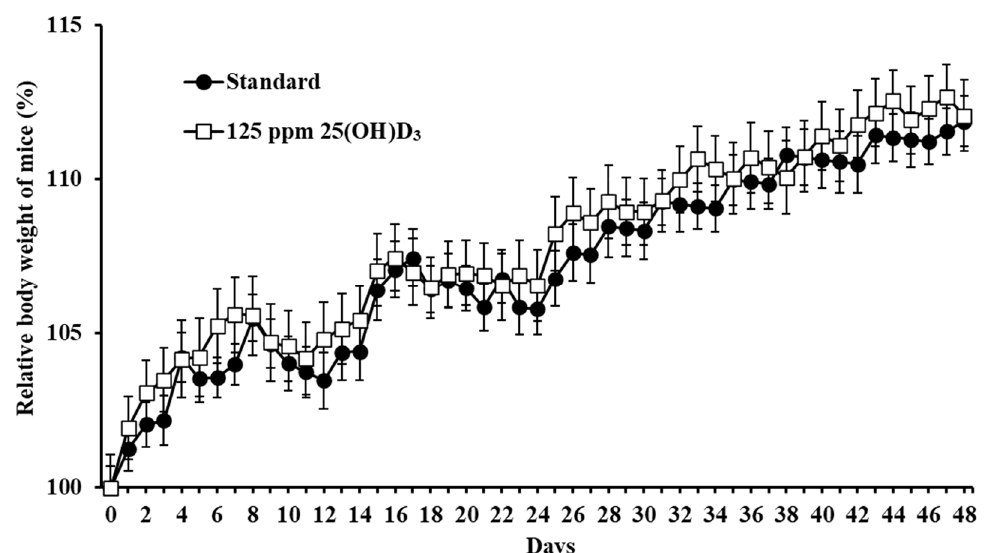
Figure 1. Changes of mouse body weight during dietary supplementation with 25(OH)D 3 for 7 weeks. Mice were divided into two groups and fed a standard diet or a 125 ppm 25(OH)D 3 -containing diet ( n = 18 mice / group). The relative body weight of each mouse was measured for 7 weeks and compared with the primary body weight at day 0.